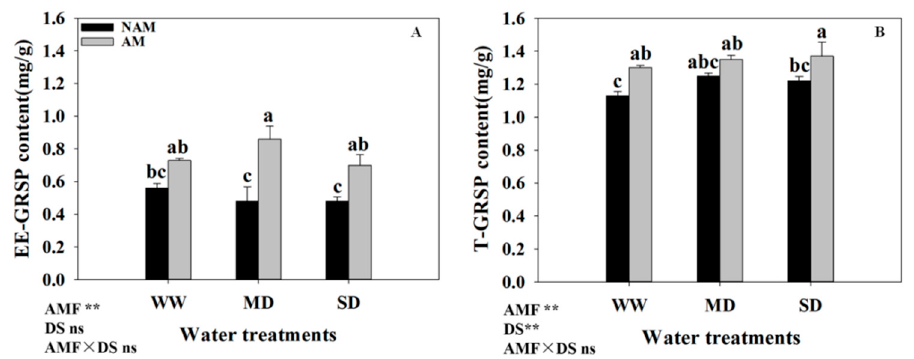
Figure 9. Effect of the arbuscular mycorrhizal fungus (AMF) Rhizophagus intraradices on the easily extractable glomalin-related soil protein (EE-GRSP) ( A ), and total glomalin-related soil protein (T-GRSP) ( B ) content in the rhizosphere soil under DS. NAM, non-AMF-inoculated; AM, AMF-inoculated; WW, well-watered; MD, moderate drought; SD, severe drought; DS, drought stress. Different lowercase letters above the bars indicate significant differences ( p < 0.05) among treatments. Values are means ± SE ( n = 3). Two-way ANOVA output: ns, not significant; ** p < 0.01.